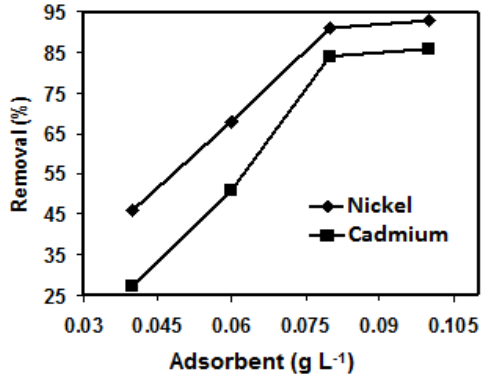
Fig. 4. Effect of pH on cadmium and nickel removal by PPI dendrimer (C 0 =100 mg/L, C adsorbent =0.08 g/L, T=298 °K)